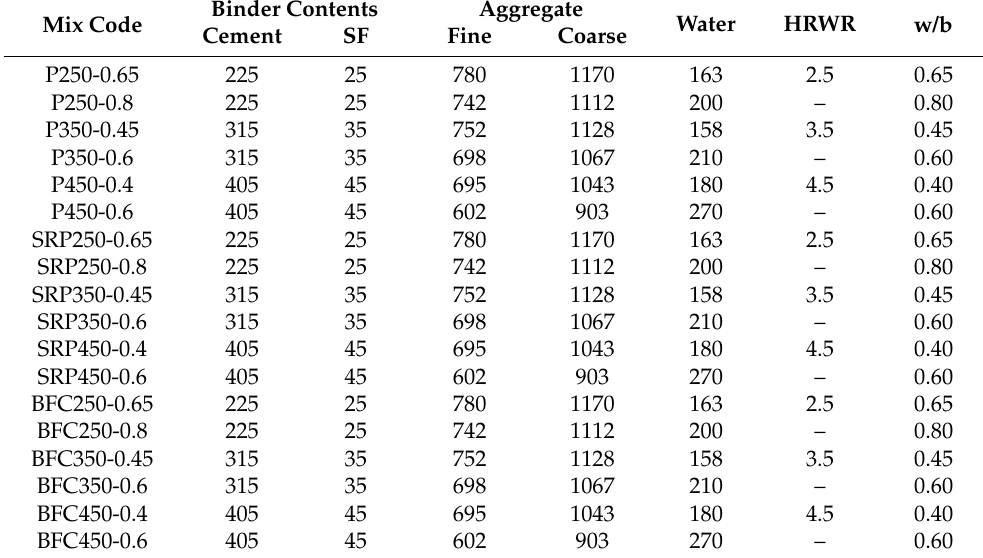
Table 4. Concrete mix proportions (kg/m 3